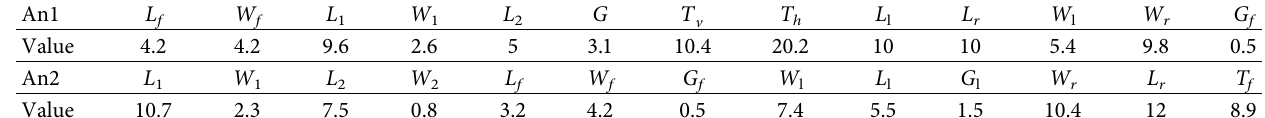
Table 2: Dimensions of the proposed antennas (unit: mm).